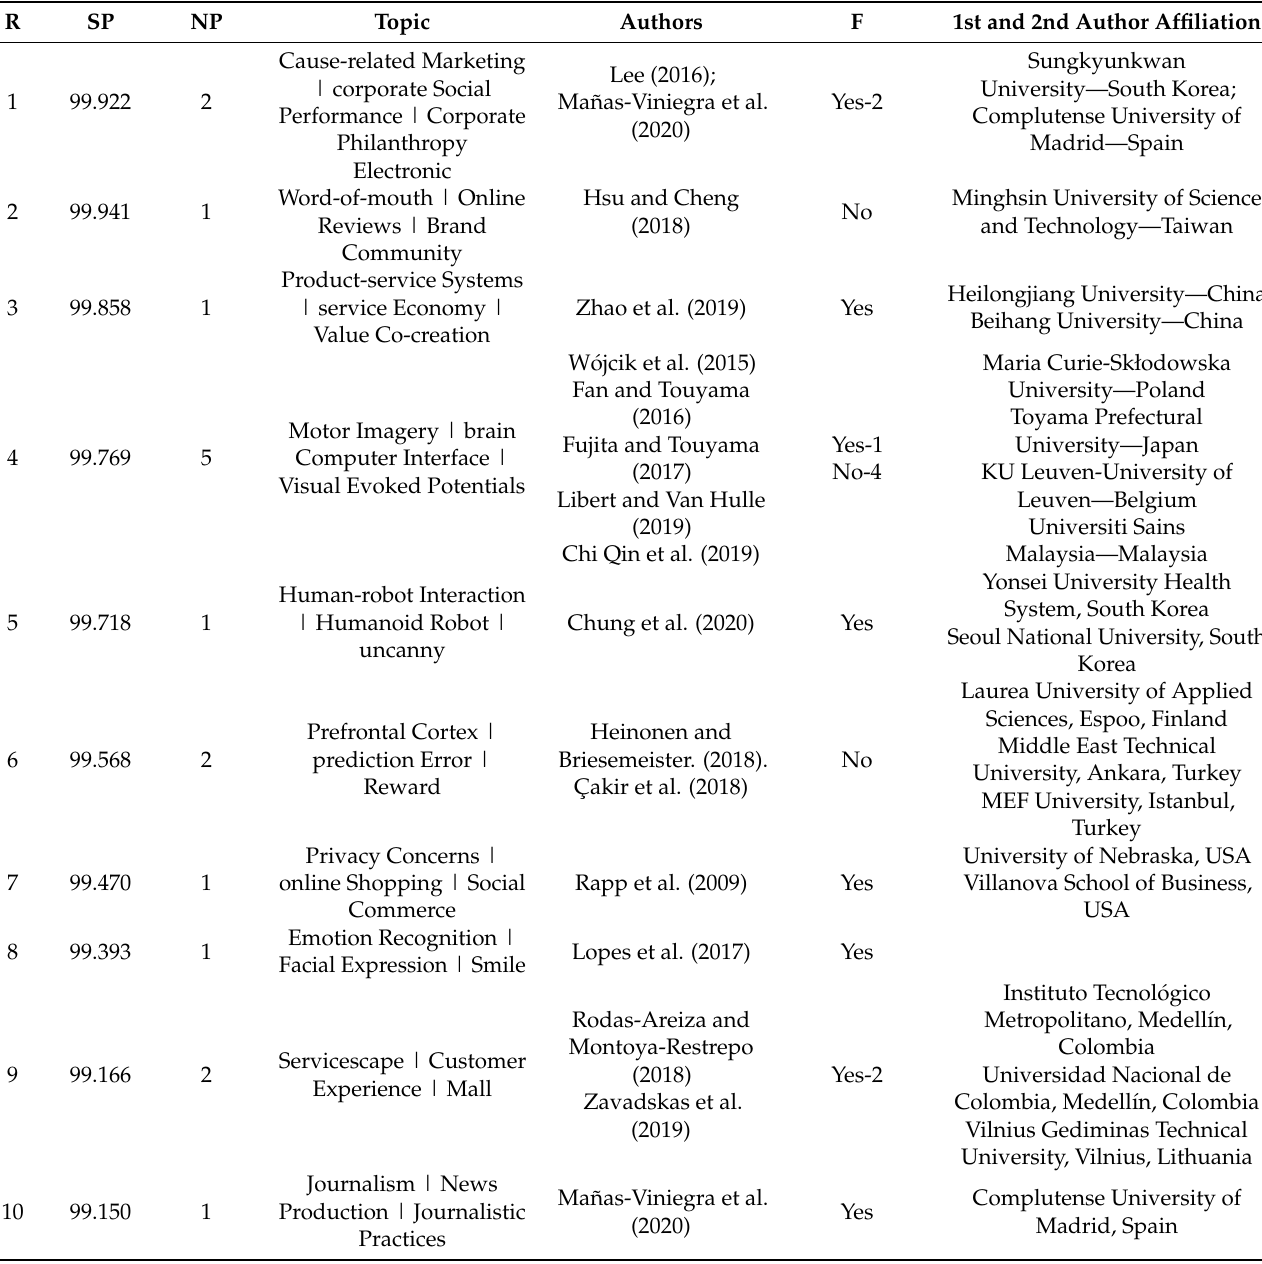
Table 8. Top ten Scival topics by best percentile: funding and author